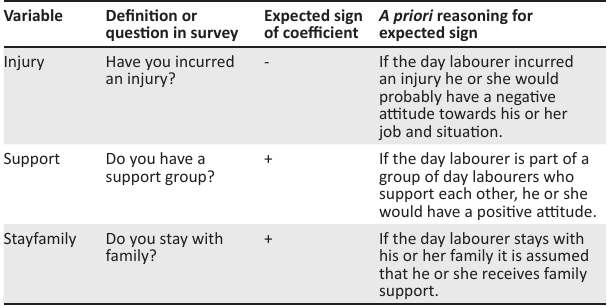
TABLE 11: Attitudinal variables.